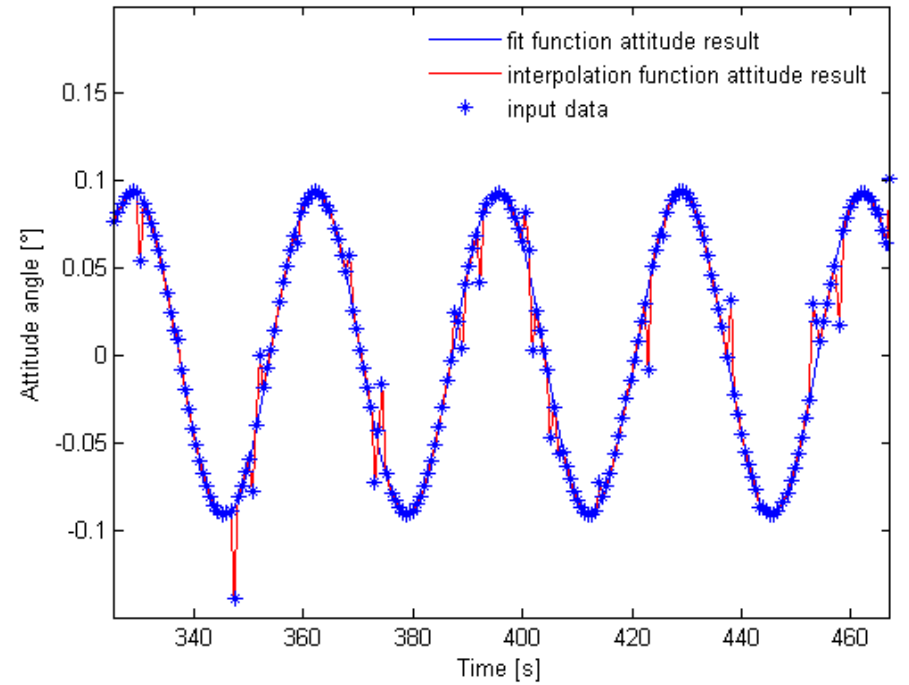
Figure 12. Optical axis angle fitting results of different fitting algorithms.